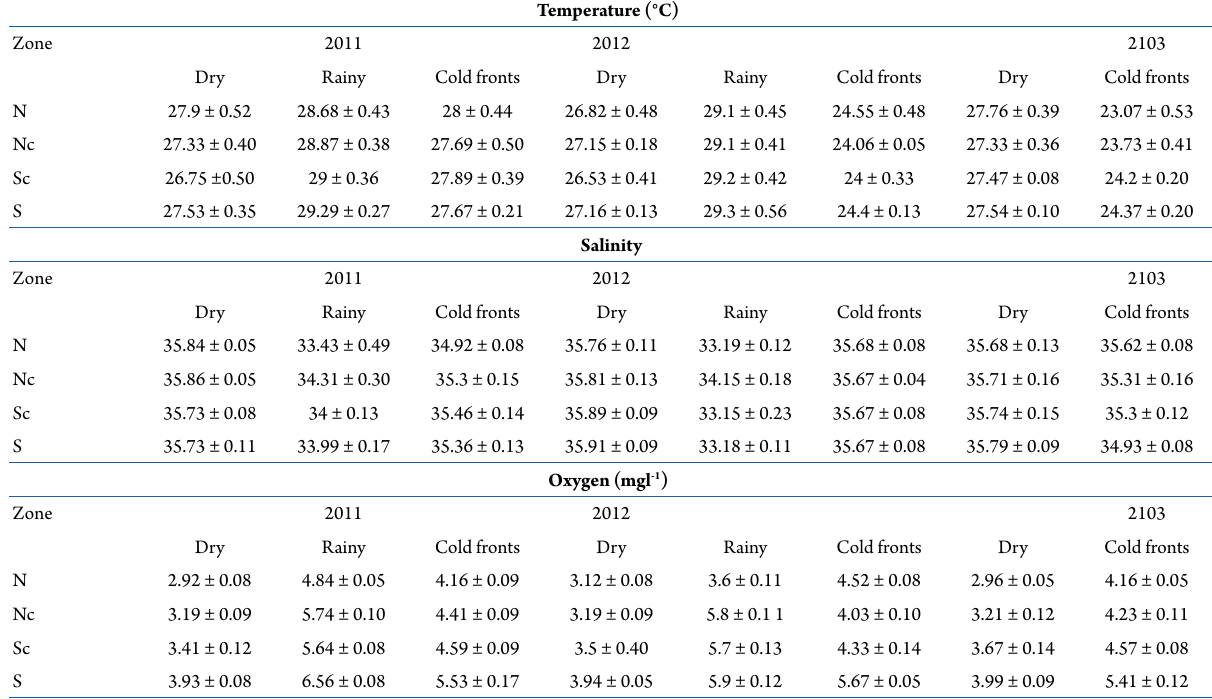
Table 1. Seasonal temperature (ºC), salinity and dissolved oxygen (mgl −l ) in three weather conditions and four transects during the years 2011, 2012 and 2013. Northern, N; North central Nc; South central, Sc; Southern, S. (±